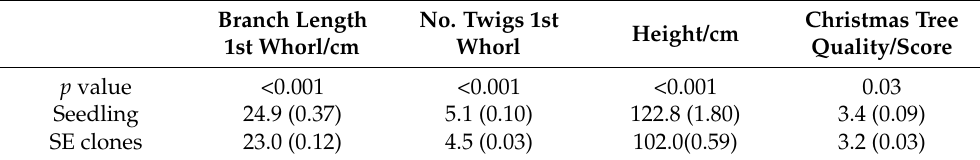
Table 2. LSmean of zygotic seedling and somatic embryogenesis (SE) clones group for traits: branch length at 1st whorl; number (No.) of twigs at 1st whorl; total height of tree; and Christmas tree quality